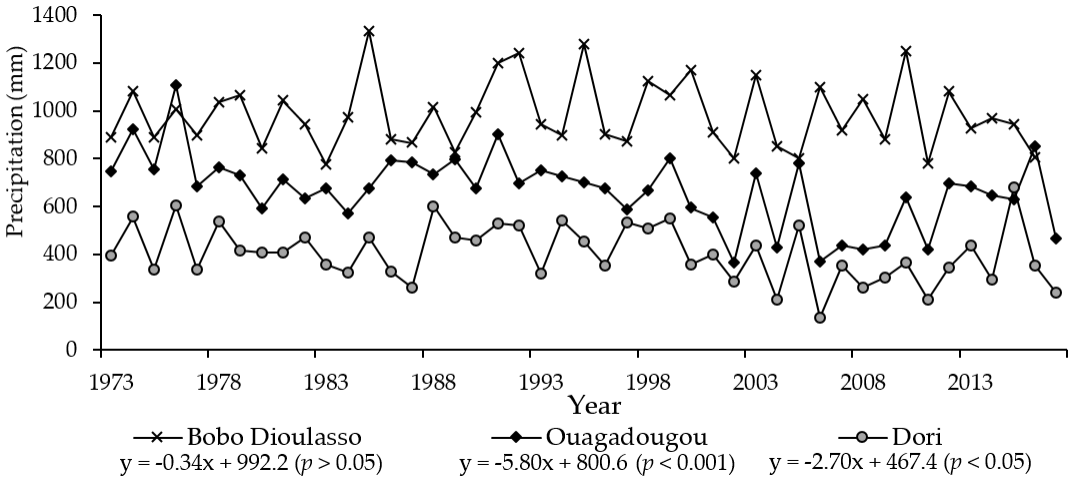
Figure 4. Total annual precipitation (mm), lineal regression, and statistical significance along the different agroclimatic zones (Soudanian, Soudano-Sahelian, and Sahelian) for the period 1973–2017. Table 4. Changes in annual precipitation ( µ) and interannual rainfall variability (cv) along the different agroclimatic zones (Soudanian, Soudano-Sahelian, and Sahelian) for the period 1973–2017.